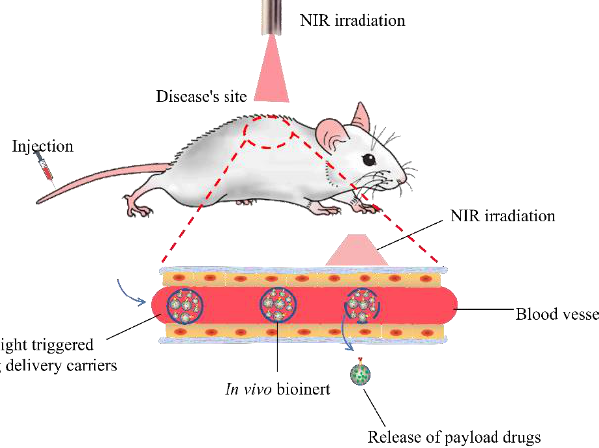
Figure 7. Scheme of the mechanism of the light-triggered drug vehicles (administered by intravenous injection and triggered by light when approaching the targeted sites).